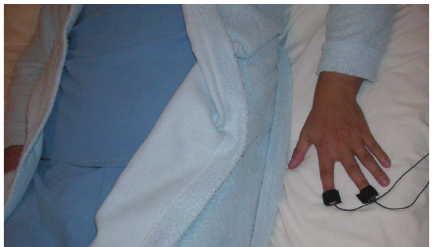
Figure 18: Placing the galvanic skin response sensor in the patient [14].